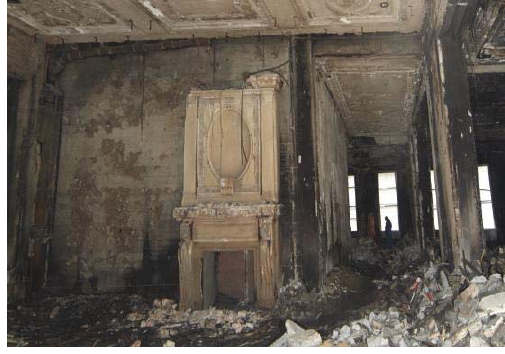
Picture 2: The same wall after the fire Reconstruction – what does it